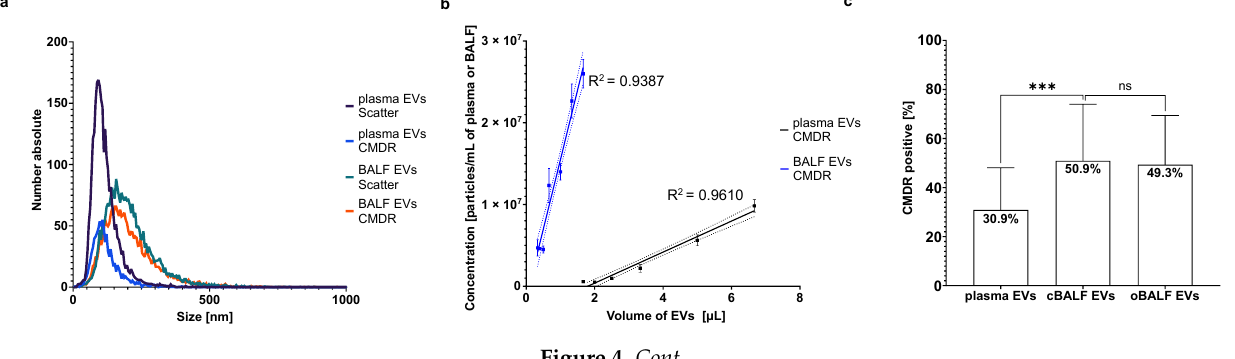
fe Figure 4. Cont